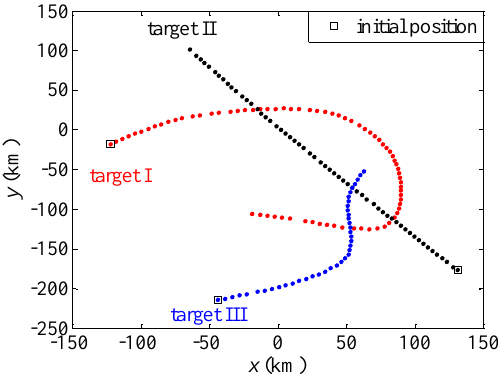
Figure 12. The real measurements for two targets. Information 2018 , 9 , x FOR PEER REVIEW